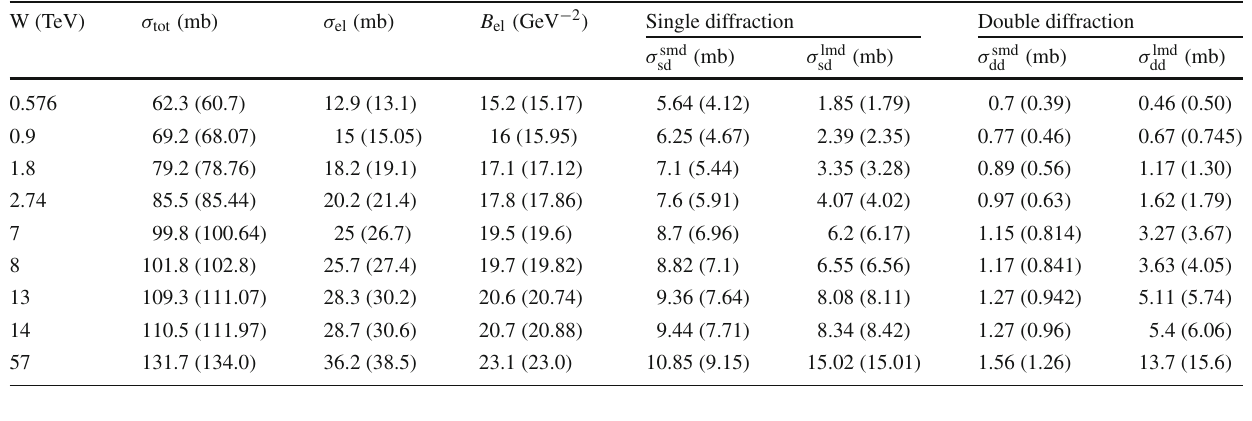
Table 2 The values of cross sections versus energy. σ smd denote the cross sections for diffraction dissociation in the small mass region, for single and double diffraction, which stem from the Good–